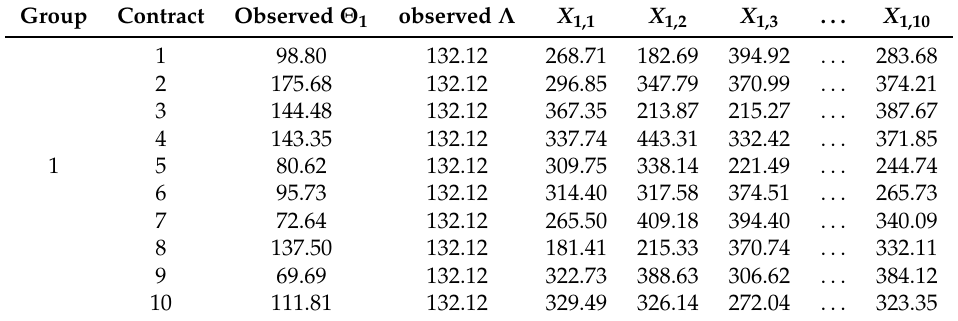
Table 1. Information of the credibility premium of ten periods for the ten individuals in the first group.